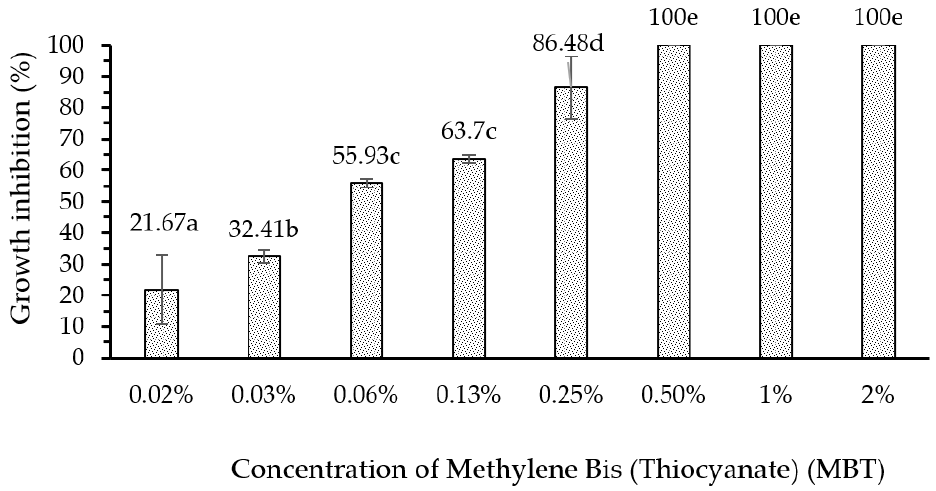
Figure 5. The inhibition rate of various concentrations of methylene bis-thiocyanate (MBT) on the growth of A. foetidus fungus. Notes: the same letter on the statistic bar indicates no significant difference ( p <